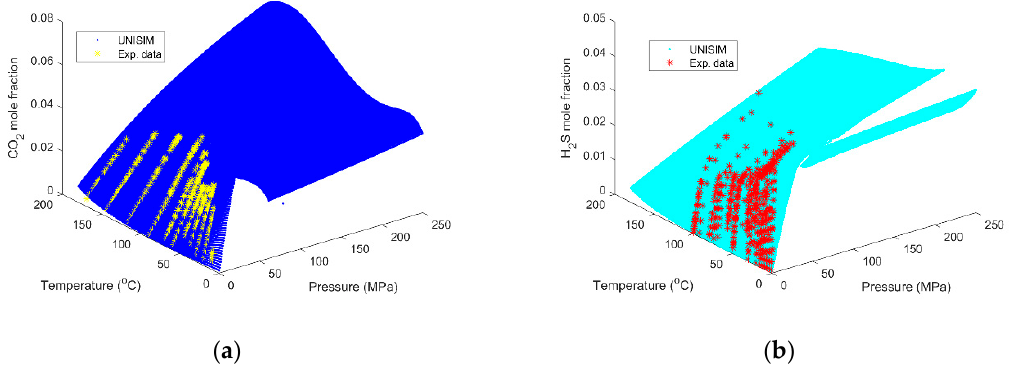
Figure 5. Evaluation of the UniSim ® results for pure CO 2 ( a ) and H 2 S ( b ) solubility.